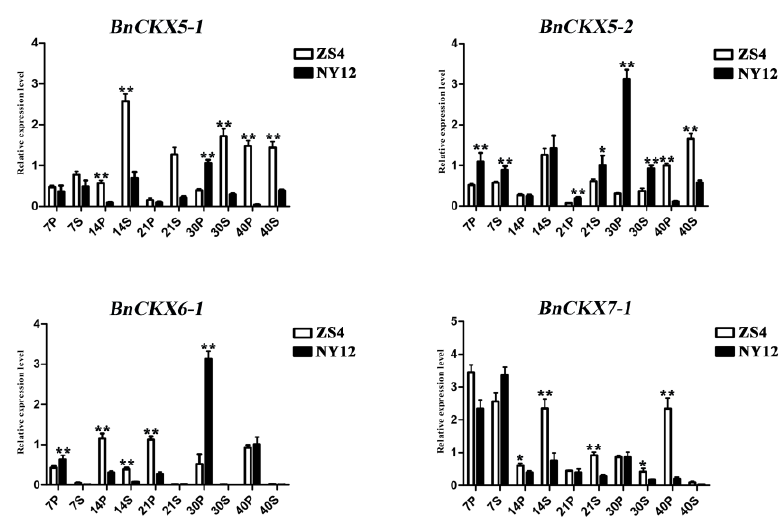
Figure 7. Differentially expressed genes between plant materials with extremely long vs short siliques; the average silique length is 9.80 cm in B. napus cultivar Zhong Shuang 4 (‘ZS4’) and 3.50 cm in Ning You 12 (‘NY12’).